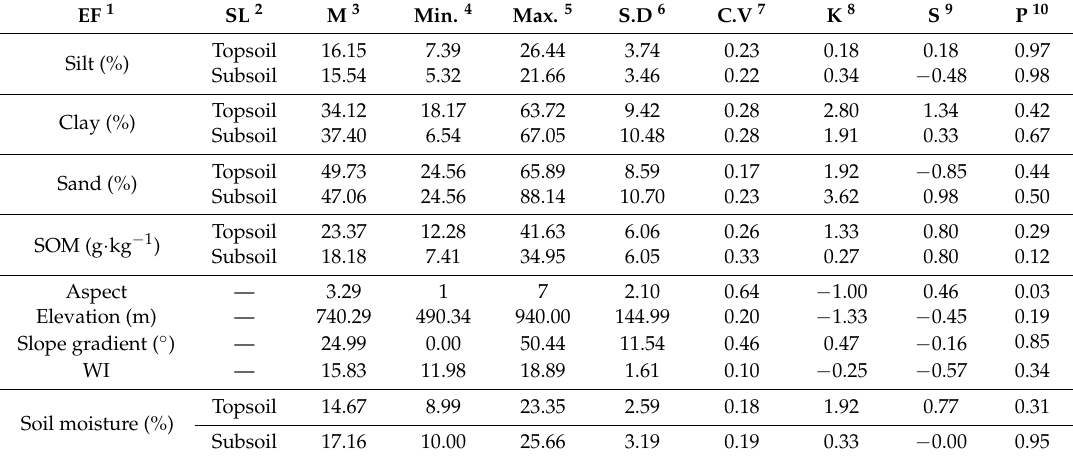
Table 1. Descriptive statistics and Kolmogorov-Smirnov test for soil properties in each soil layer and topographic factors (aspect, elevation, and slope gradient), WI and average soil moisture in the topsoil and subsoil layer for 51 sampling points.